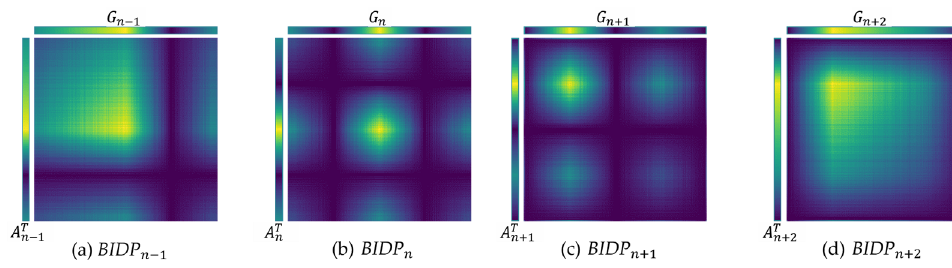
Figure 2. Example of 𝐵𝐼𝐷𝑃 visualization.